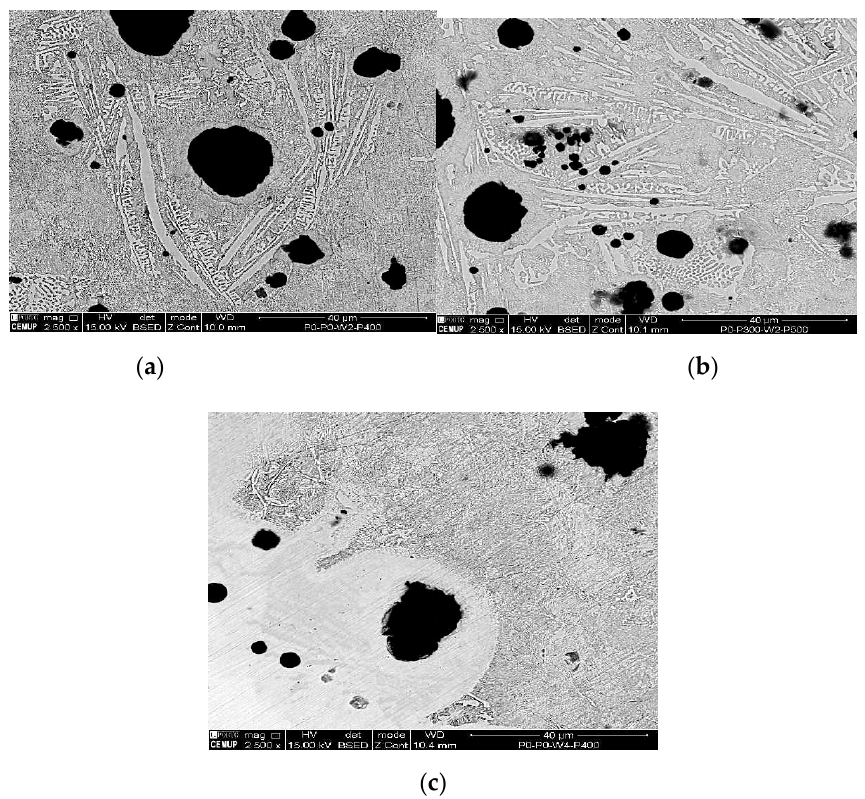
Figure 6 . SEM analysis of the experimental samples etched with 4% Nital and 2500x magnification: ( a ) sample 1P0W2P400 (UTS 390.0 MPa), ( b ) sample 2P300W2P300 (UTS 394.2 MPa), and ( c ) sample 1P0W4P400 (UTS 394.0 MPa) .